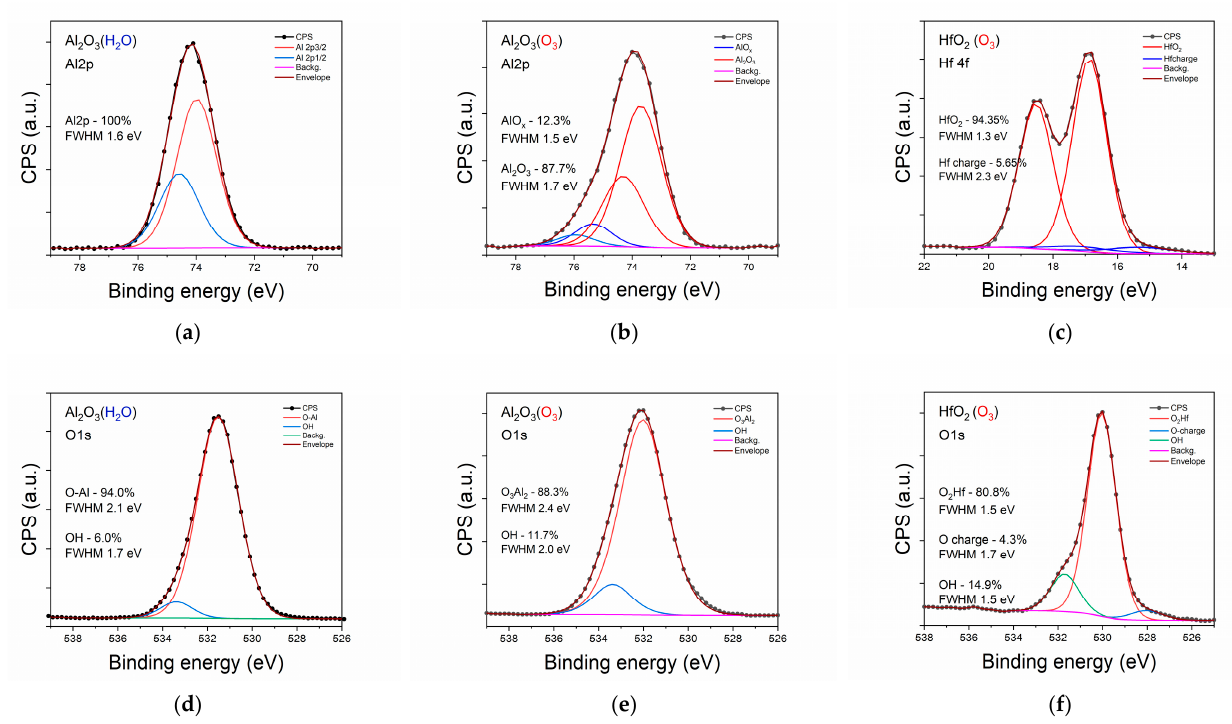
Figure 2. High-resolution spectra for metals and oxygen for investigated samples of pure Al 2 O 3 and HfO 2 as measured for bulk, after short Ar + sputtering to remove surface contamination Al line: ( a – c ), O line ( d – f ).